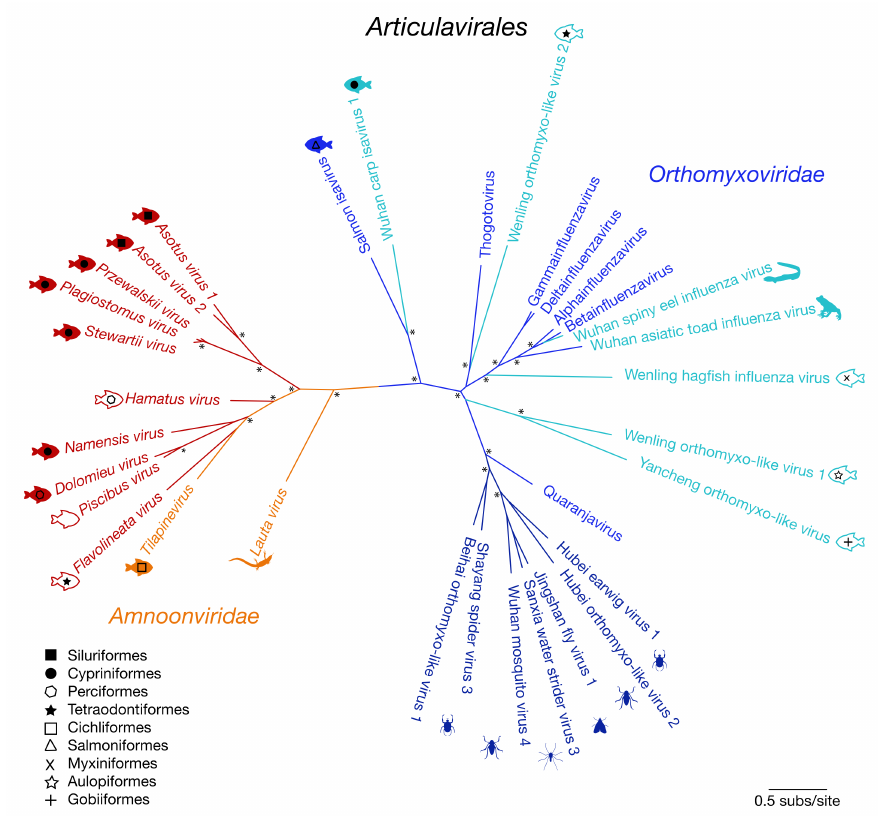
Figure 2. Unrooted maximum likelihood phylogenetic tree of the PB1 subunit showing the topological position of 10 of the 11 newly discovered viruses (red) that shared sequence similarity to segment 1 within the order Articulavirales ( Amnoonviridae : orange; Orthomyxoviridae : shades of blue). Tilapinevirus (TiLV) and the recently discovered Lauta virus were the only viruses previously identified in this family. Fish viruses are annotated with fish symbols (filled: freshwater; outline: marine), and fish order corresponds to shapes illustrated by the key. All branches are scaled according to the number of amino acid substitutions per site. An asterisk (*) illustrates nodes with bootstrap support >